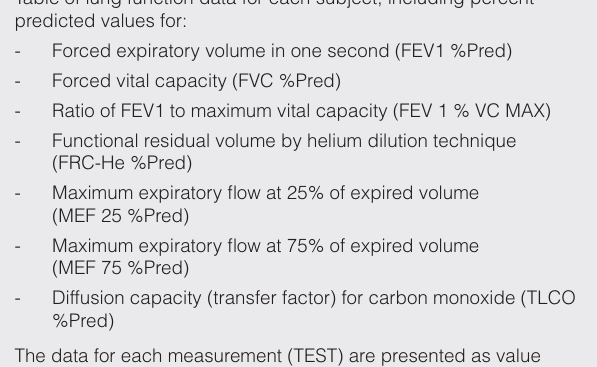
Diffusion capacity (transfer factor) for carbon monoxide (TLCO %Pred) The data for each measurement (TEST) are presented as value (standard result, STRESN), together with the visit number (VISITNUM) at which measurements were